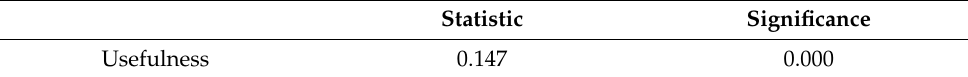
Table 9. Normality tests.